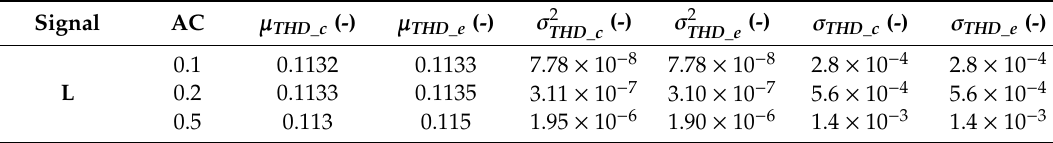
Table 13. Results of test, for signal L and for the 3 accuracy classes, with the simplified expression.